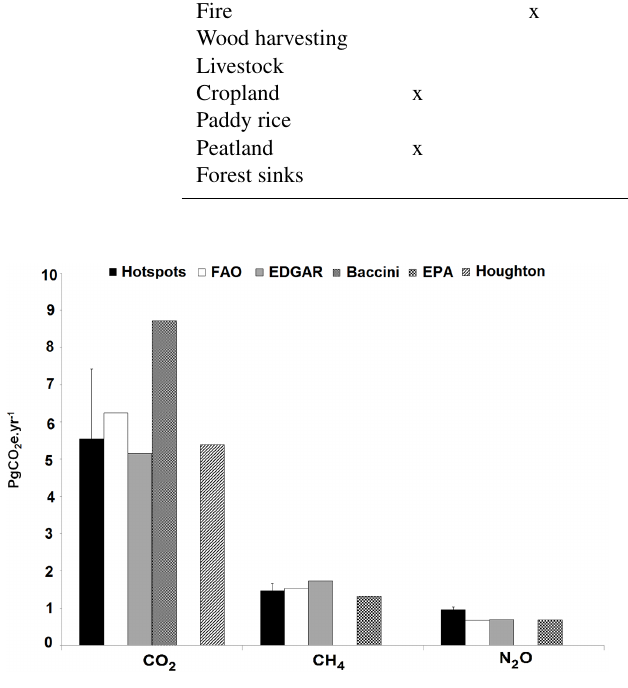
Figure 5. Contribution of the different AFOLU greenhouse gases (CO 2 , CH 4 , N 2 O) from the different datasets. Uncertainties are only provided in the Hotspots dataset (1 σ from mean). EPA data do not include forest emissions. Houghton and Baccini are FOLU (Forestry and Other Land Use) CO 2 -only datasets and do not in- clude agricultural emissions. Houghton offers net emissions while Baccini data are gross emissions for deforestation, fire, and wood harvesting (Baccini et al.,